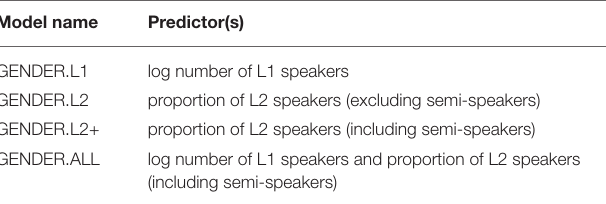
TABLE 5 | Model names and predictors in case study